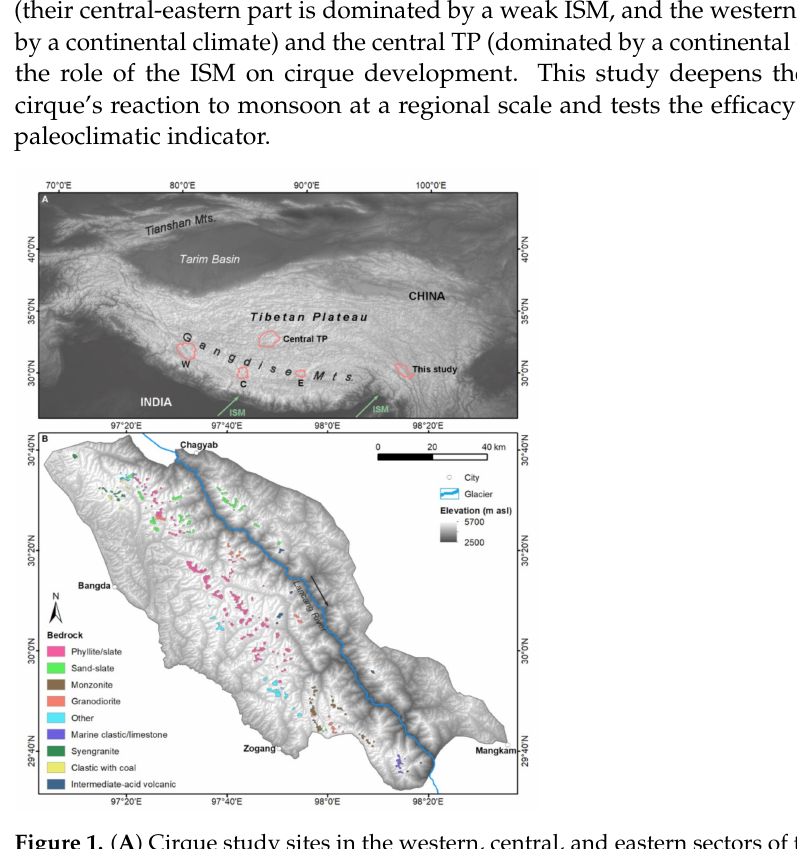
Figure 1. ( A ) Cirque study sites in the western, central, and eastern sectors of the Gangdise Moun- tains [7], the central TP [6], and this study; ( B ) cirque locations and bedrock types of the study area. 2. Study